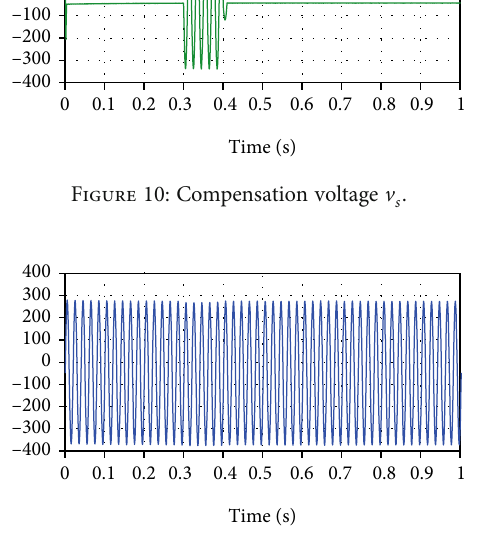
Figure 11: Voltage v compensation.